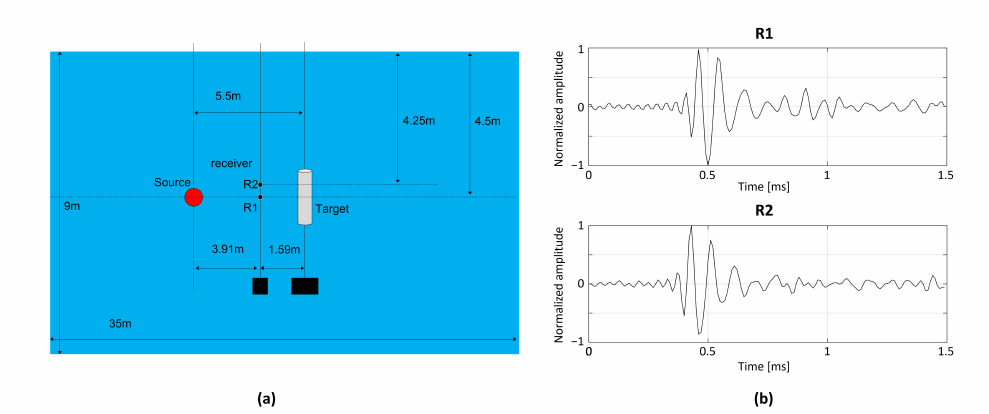
Figure 7. ( a ) Experimental environment; transmission signals are scattered by cylindrical shell and are received by two receivers at different water depths. ( b ) Portion of acoustic signals at two receivers after pulse compression (R1 and R2), which include intensive specular echoes and weak elastic surface